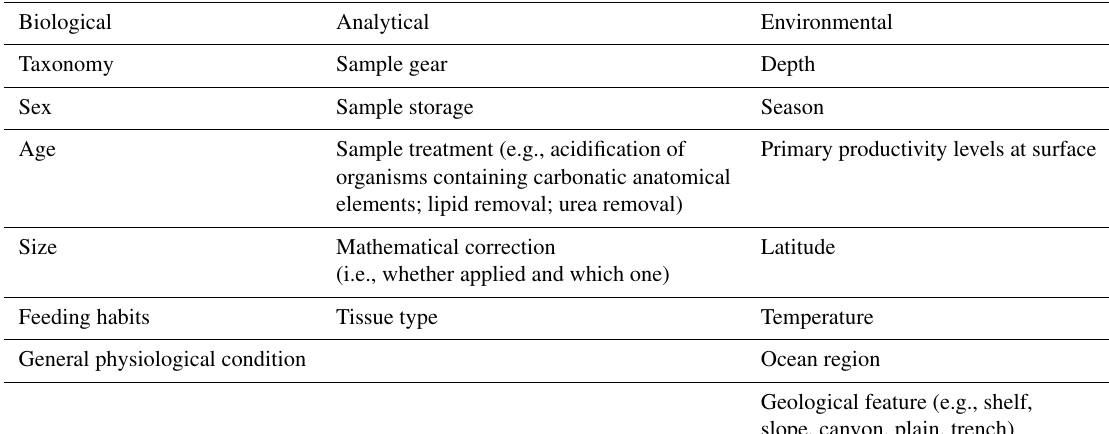
Table 2. Sources of variations across studies, distinguished by type (i.e., biological, environmental, analytical).